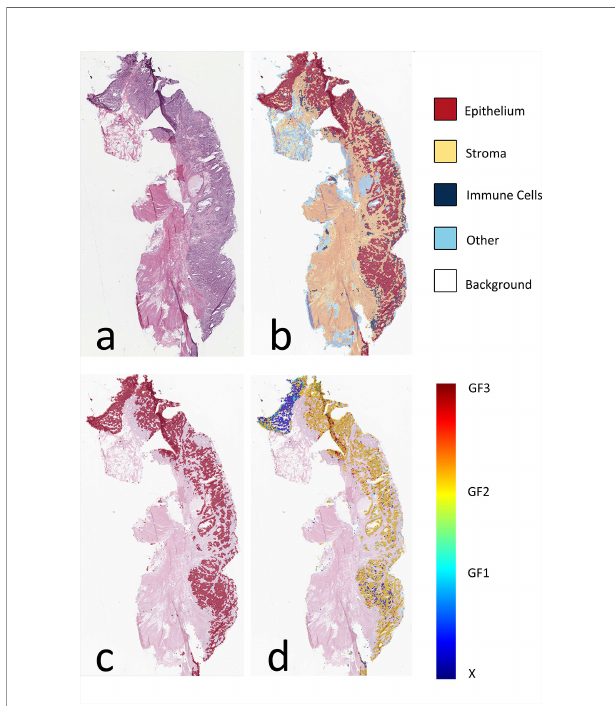
FIGURE 3 | Visual presentation of tissue category and gland formation. (A) Thumbnail of original WSI. (B) The fusion map of the thumbnail and tissue category map. Different colors represent corresponding tissue categories, and the details can be seen in the right side legend. (C) The fusion map of the thumbnail and the epithelium mask selected from panel (B, D) The fusion map of the thumbnail and gland formation from the linear predictor on panel (C) epithelium mask. WSI, whole-slide